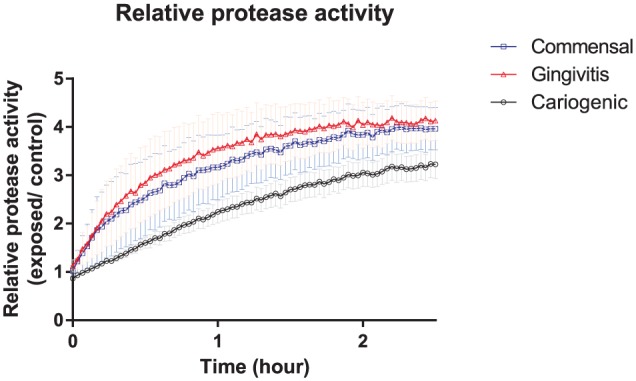
The protease activity of the culture supernatant of gingiva equivalents
exposed to 107 colony-forming units of commensal (blue
squares), gingivitis (red triangles), or cariogenic (black circles)
biofilms was measured by fluorescence resonance energy transfer over 2.5
h and represented relative to unexposed controls. The gingivitis
biofilms caused the highest protease activity, followed by the commensal
biofilms, and the cariogenic biofilms caused the least protease
activity. Data represent the mean ± SEM of 3 individual experiments in
duplicate.